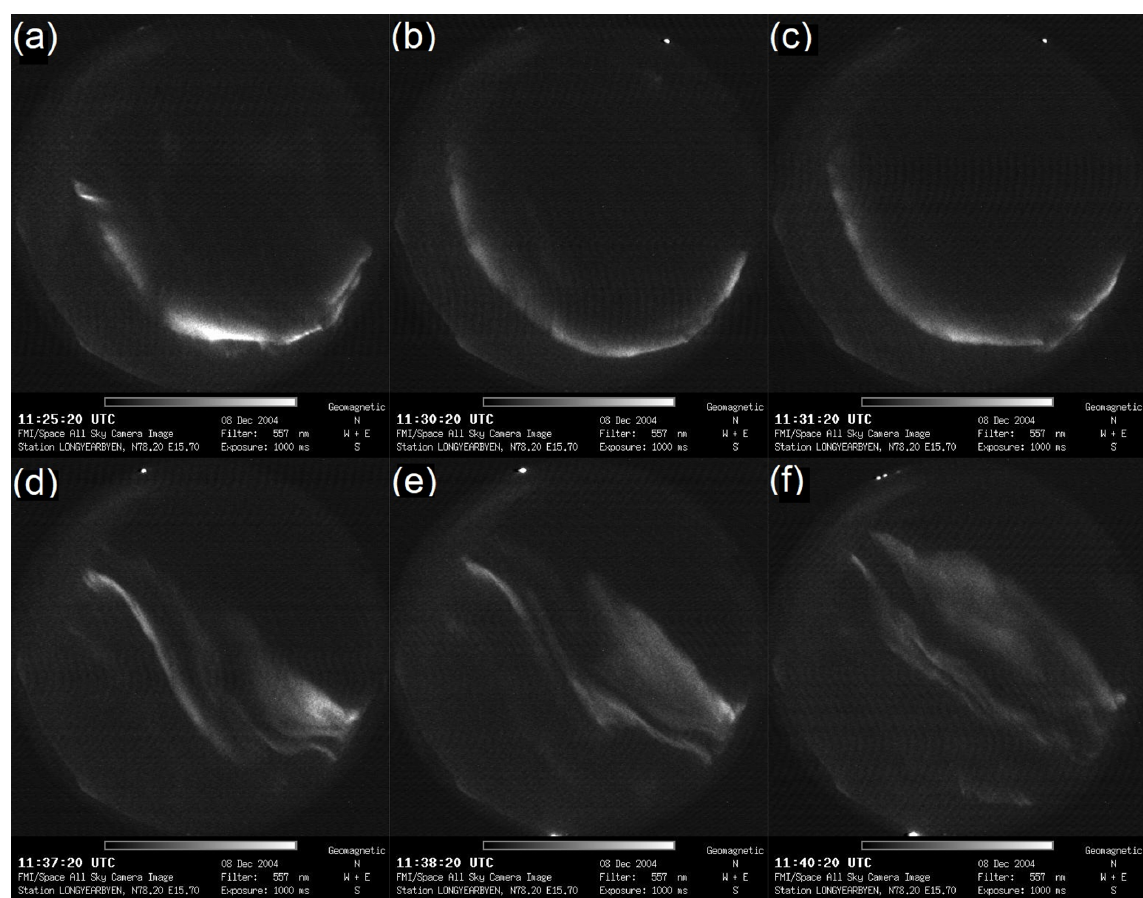
Figure 7. Several ASC images mounted with a narrow-band filter ( λ = 557.7nm) portraying the typical evolution of a PMAF. Compared to Figs. 2 and 3, the orientation of the images here is flipped (see compass